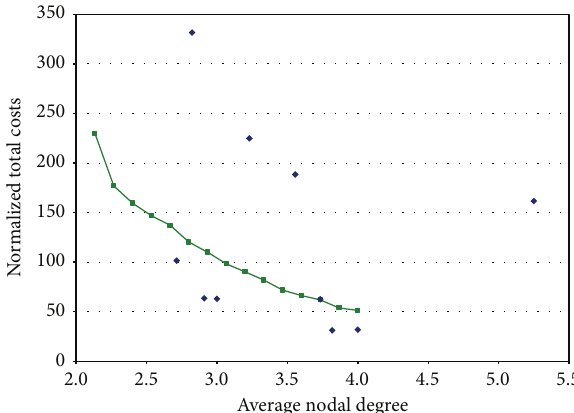
Figure 23: Normalized span restoration JCA total capacity costs.